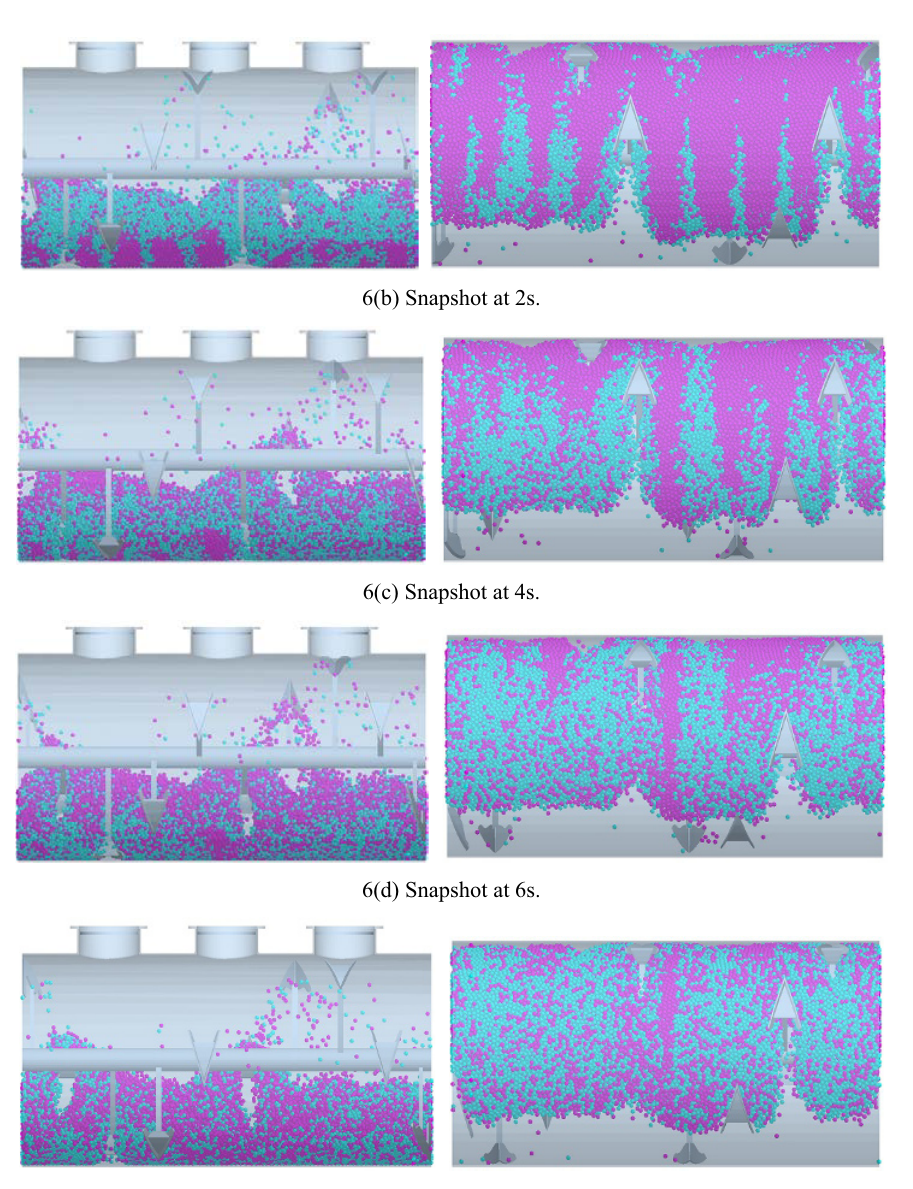
Fig. 6. Mixing process of Exp.